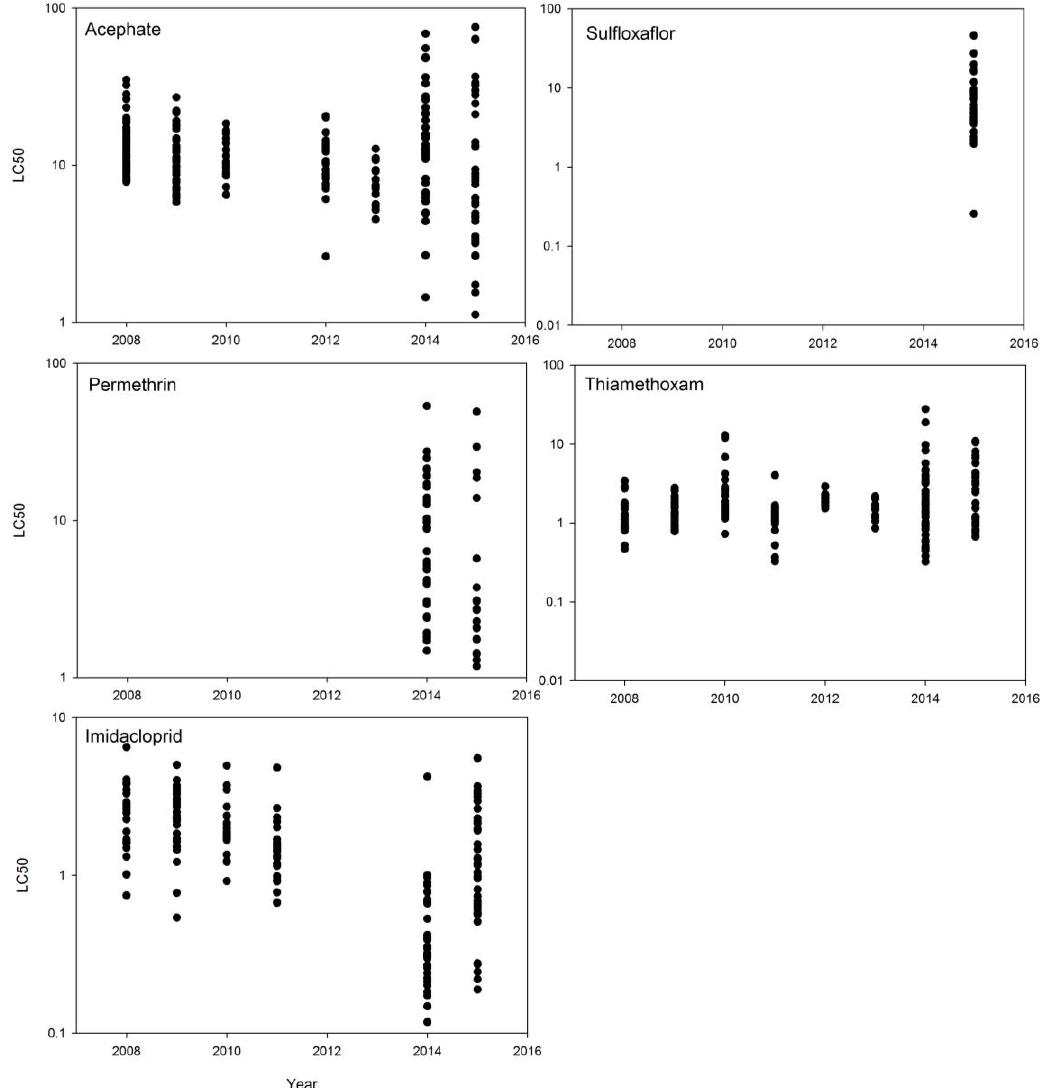
Figure 3. LC 50 s ( µ g of insecticide/vial) for tarnished plant bug populations from the Mississippi Delta exposed to acephate (vial 24 h), sulfloxaflor (vial 24 h), permethrin (vial 24 h), thiamethoxam (foam 24 h), and imidacloprid (foam 72 h 2008–2013; foam 24 h 2014–2015); LC 50 s from 2014–2015 are converted (by 3.33) to be on the same relative scale as previous bioassays from 2008 to 2015.